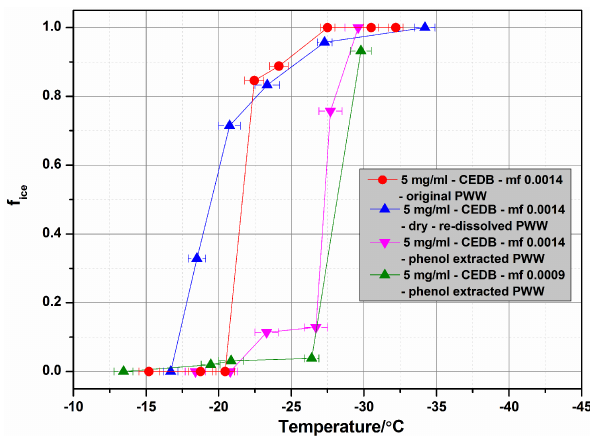
Figure 8. Freezing fraction of 5mgmL − 1 birch PWW with and without phenol extraction. Blue triangles: re-dissolved PWW after initial dehydration (mf = 0.0014). Pink triangles: PWW extracted with phenol (mf = 0.0014). Green triangles: PWW extracted with phenol (mf = 0.0009). Red circles are the same data as shown in Fig. 7 (mf =